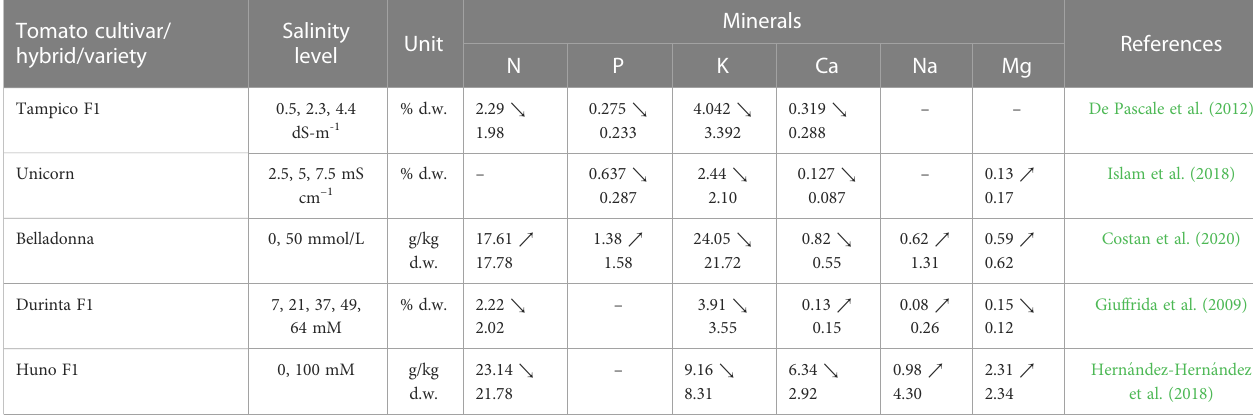
TABLE 7 Salinity impact on mineral content in tomato fruit. Tomato